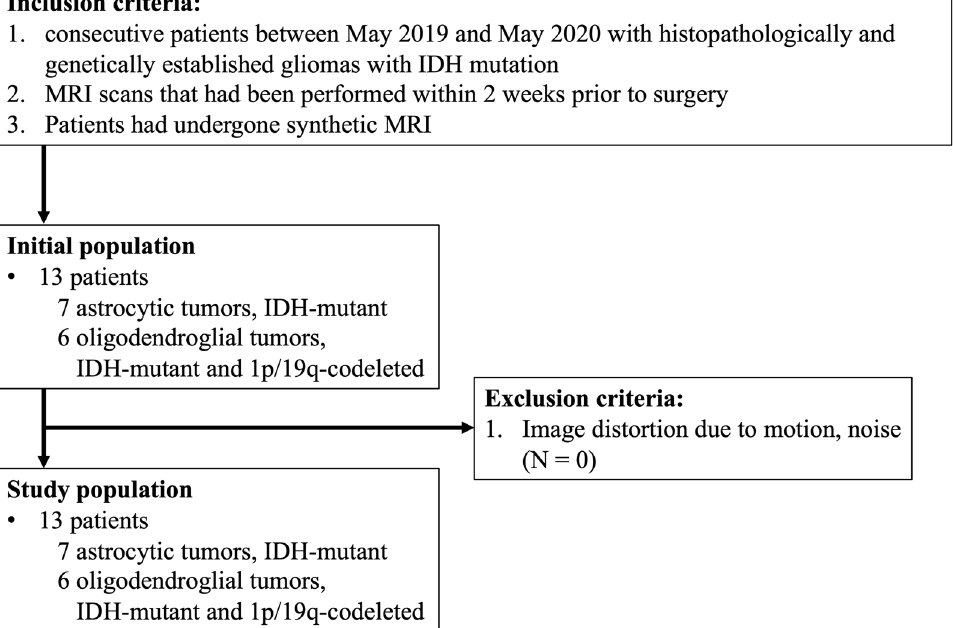
Figure 1. Patient selection flowchart.